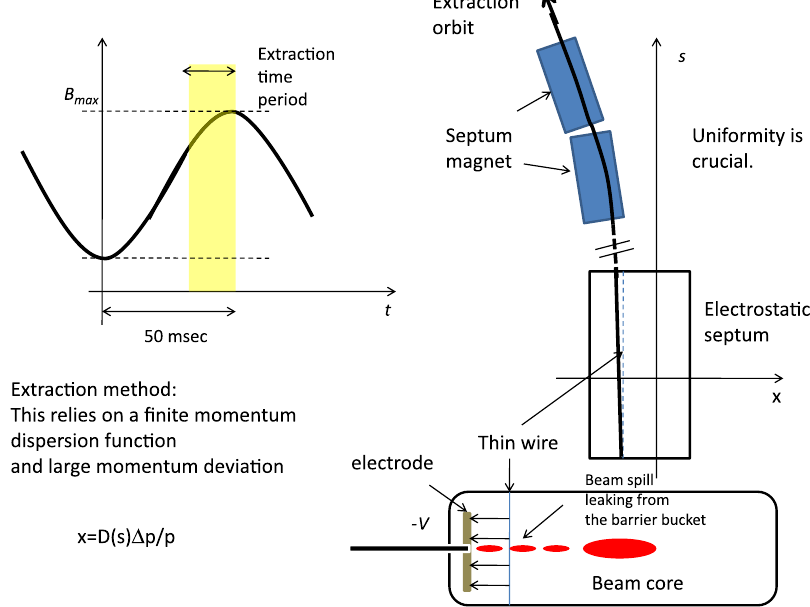
FIG. 4. Essential feature of energy sweep